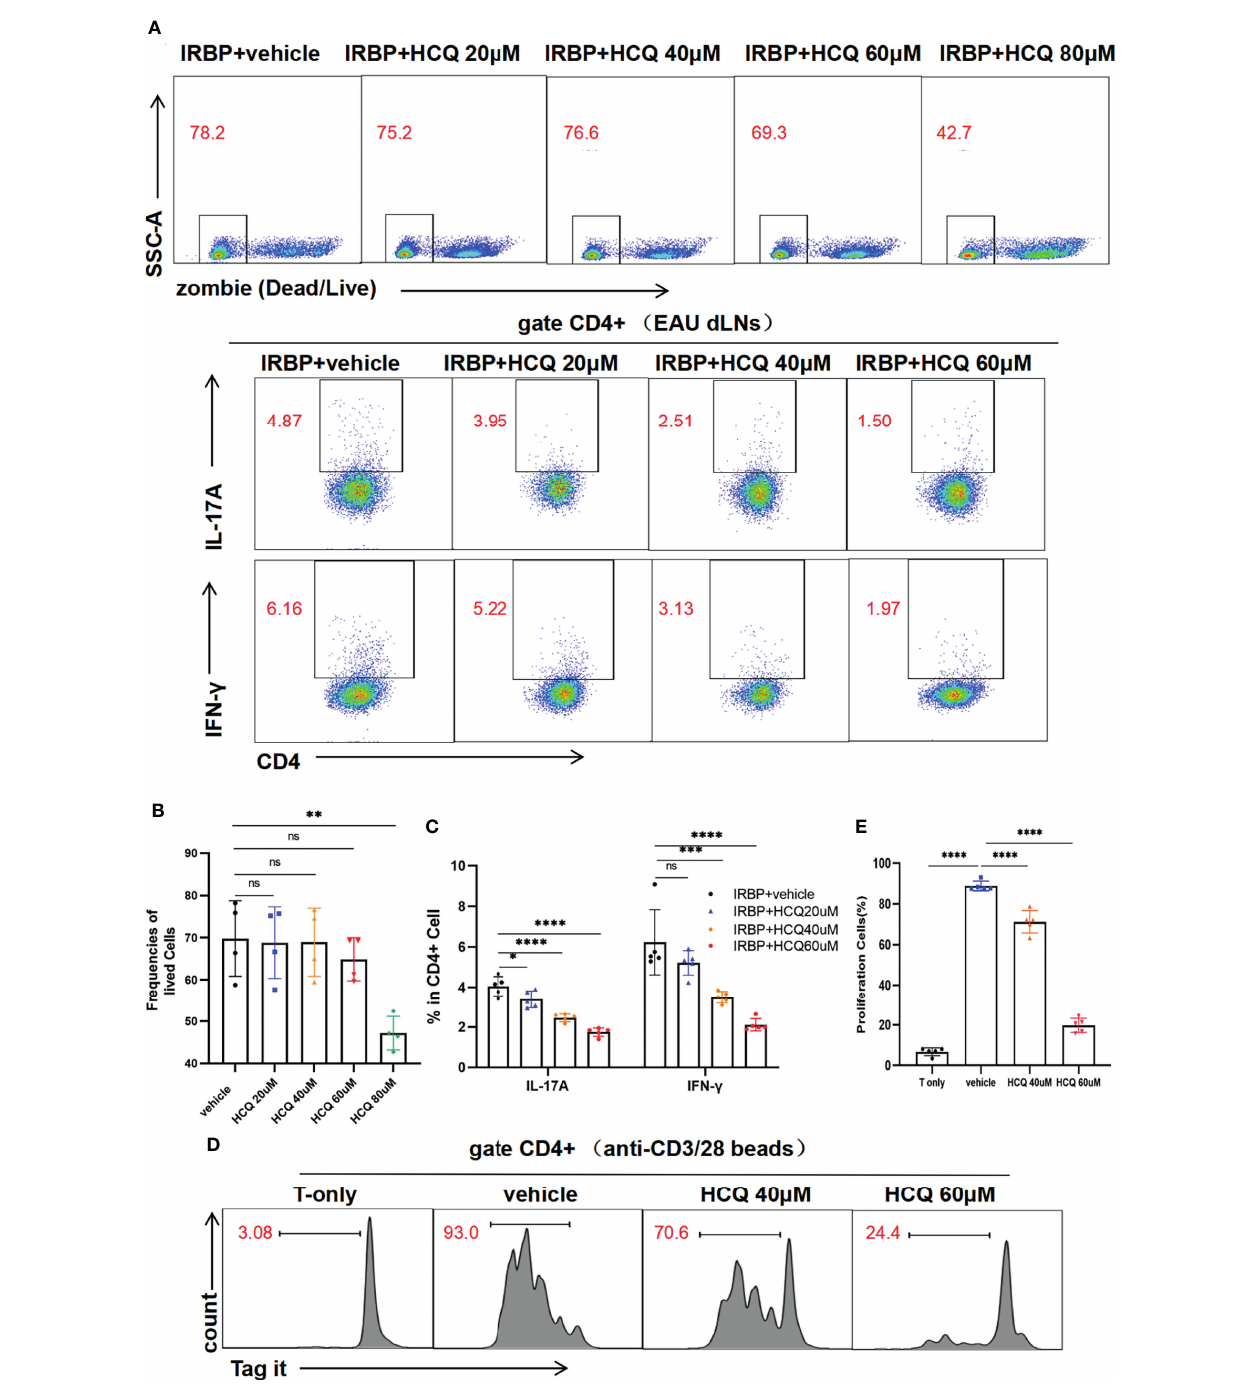
FIGURE 3 | Hydroxychloroquine (HCQ) suppresses the differentiation and proliferation of T cells. (A – C) The lymphocytes from draining lymph nodes (dLNs) of experimental autoimmune uveitis (EAU) mice were isolated and cultured in vitro with hIRBP 1-20 for 3 days. The percentages of viable lymphocytes (zombie-) were similar at concentrations of 0, 20, 40, and 60 m M of HCQ, whereas 80 m M HCQ treatment decreased the percentage. HCQ (40 and 60 µM) suppressed the differentiation of Th17 and Th1 cells signi fi cantly with statistical differences, and 20 µM HCQ suppressed Th17 differentiation similarly (N= 5). (D, E) The labeled T cells were sorted and activated with anti-CD3/CD28 beads for 4 days. HCQ (40 and 60 µM) inhibited the proliferation of CD4 + T cells obviously with statistical difference (N=5). The data are presented as the mean ± SD ( ns P > 0.05, *P < 0.05, **P < 0.01, ***P < 0.001, ****P <